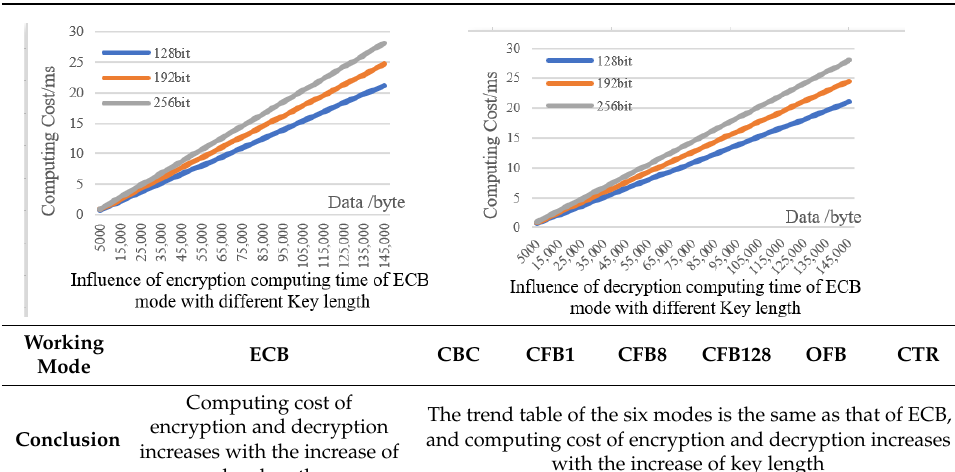
Table 2. Encryption and decryption efficiency with different key lengths.